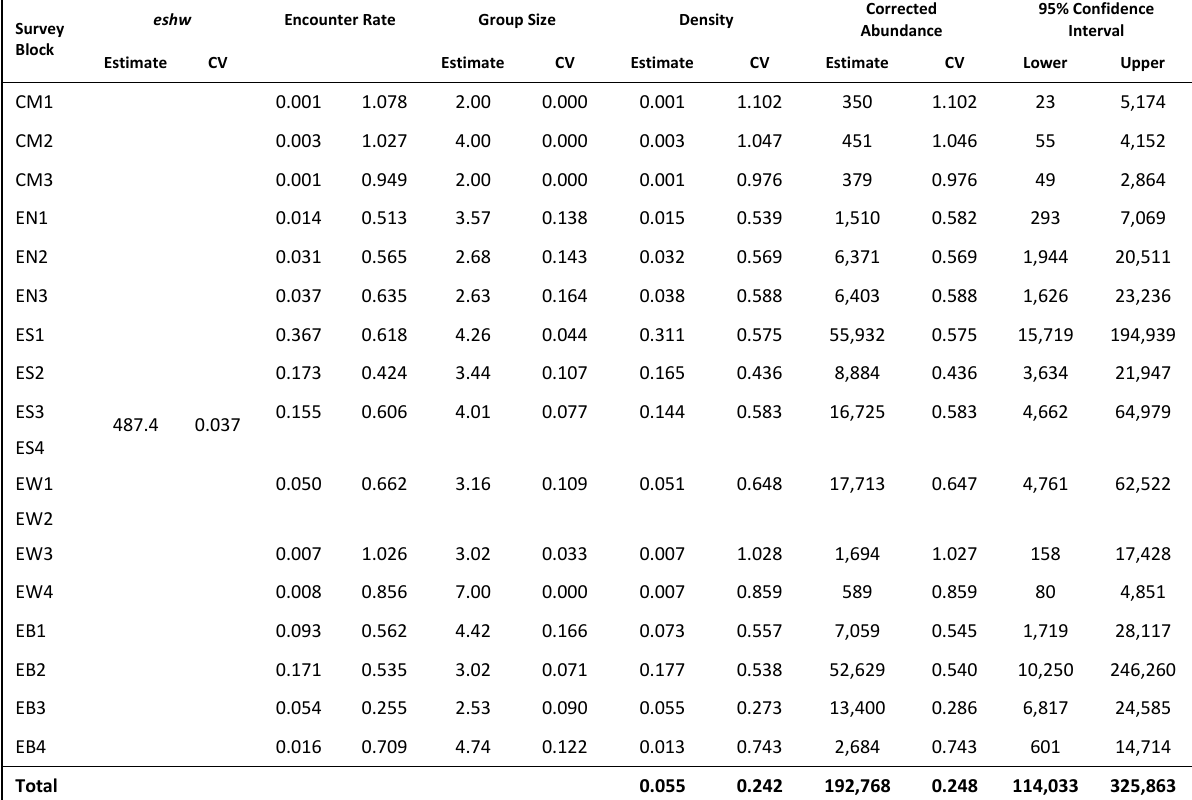
Table 11. Estimated density and abundance of Lagenorhynchus spp . The eshw (effective search half width (m)) was estimated for the entire study area. Encounter rate, group size, density, abundance, and upper and lower confidence limits were estimated by block and corrected for perception bias, with the estimated p (0).